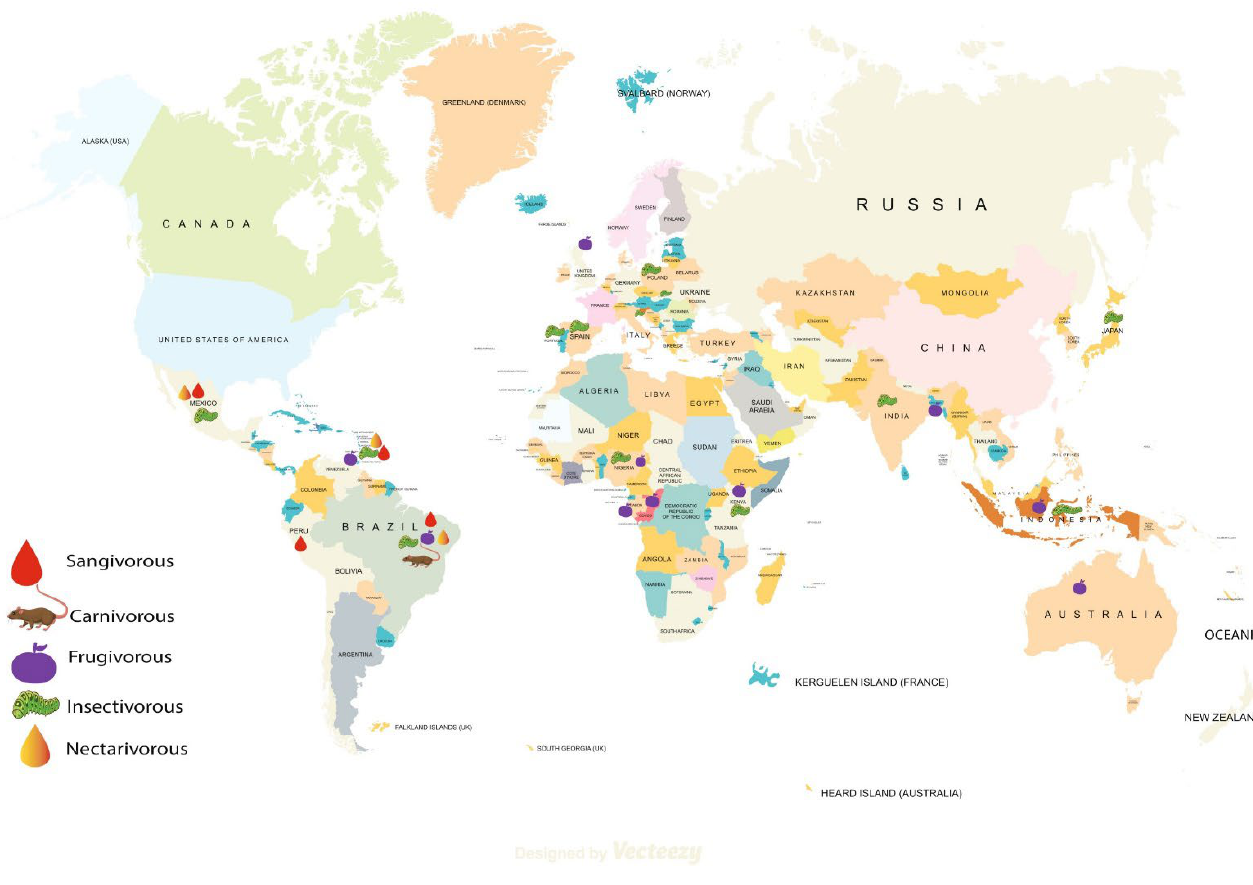
Figure 2. Geographic distribution of bat species in the included studies .